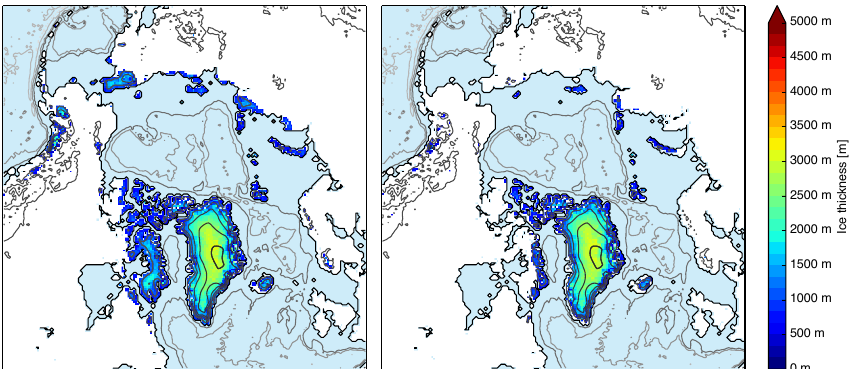
Figure 10. Ice distribution in the Northern Hemisphere for uncorrected preindustrial conditions (PI uc , left) and with subtracted temperature bias (PI bs , right). Simulated ice volumes correspond to − 8.2ms . l . e . − 4.1ms . l . e . , respectively, where the difference is mainly due to ice masses outside